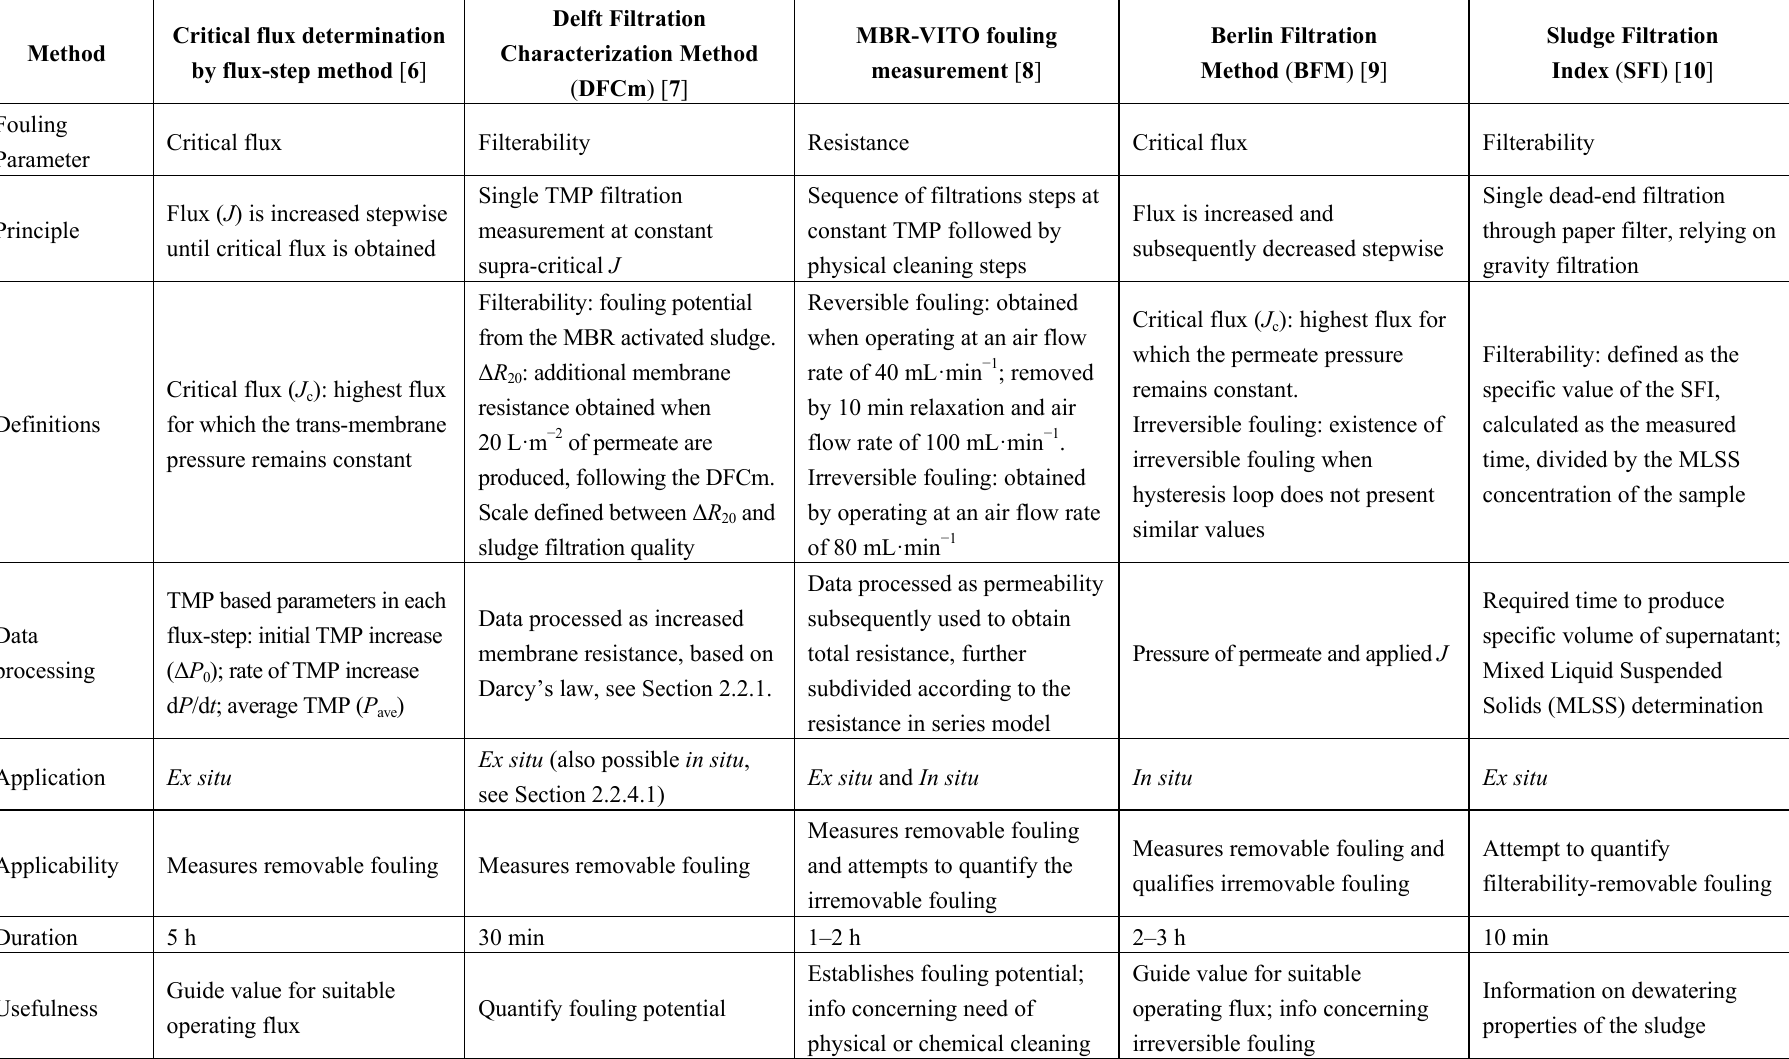
Table 1. Methods to qualify and quantify the fouling potential in Membrane Bioreactors